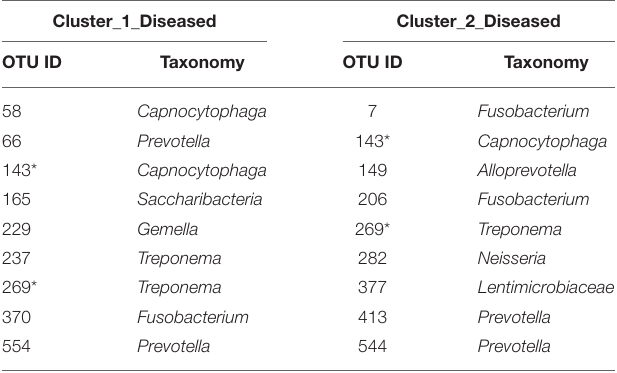
TABLE 3 | Gatekeepers in the two OP bacterial networks of the two clustered H7N9 microbiotas identified by fragmentation analysis. Cluster_1_Diseased